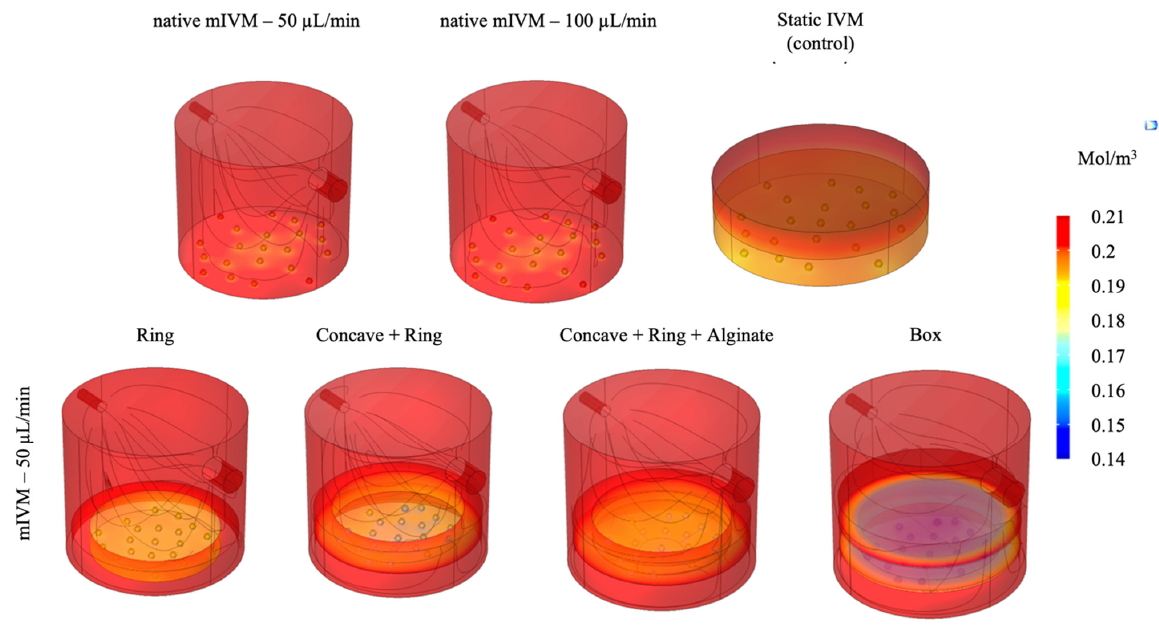
Figure 7. Computational fluid dynamic (CFD) and oxygen convection-reaction-diffusion (CRD) models of the examined conditions. Grey lines show the flow streamlines and the right bar indicates oxygen concentration in color scale from red (maximum concentration) to blue (minimum concentration).